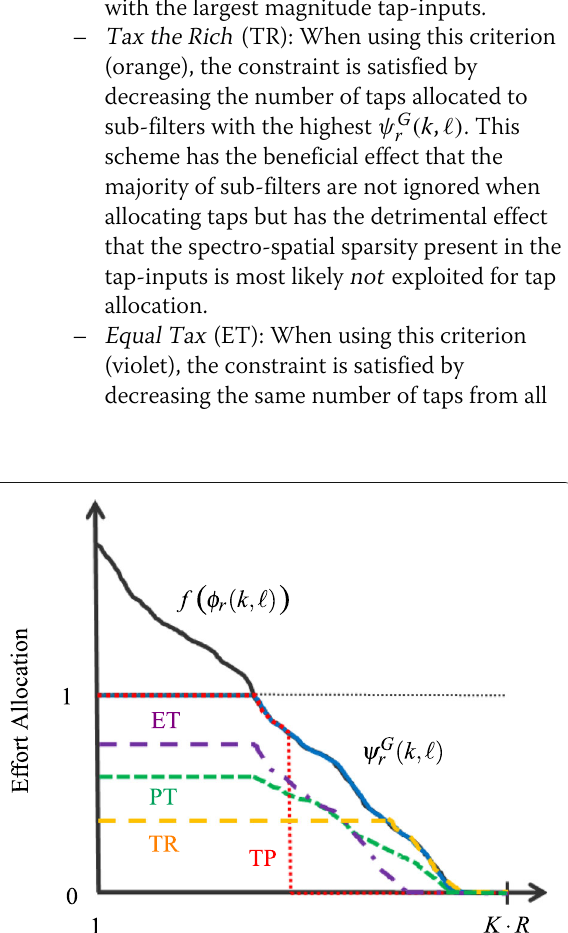
Fig. 2 Exemplary function f plotted in sorted order of highest to lowest values, along with different criteria for modifying ψ G r ( k , (cid:2)) in case M G ((cid:2)) < Q · K · R